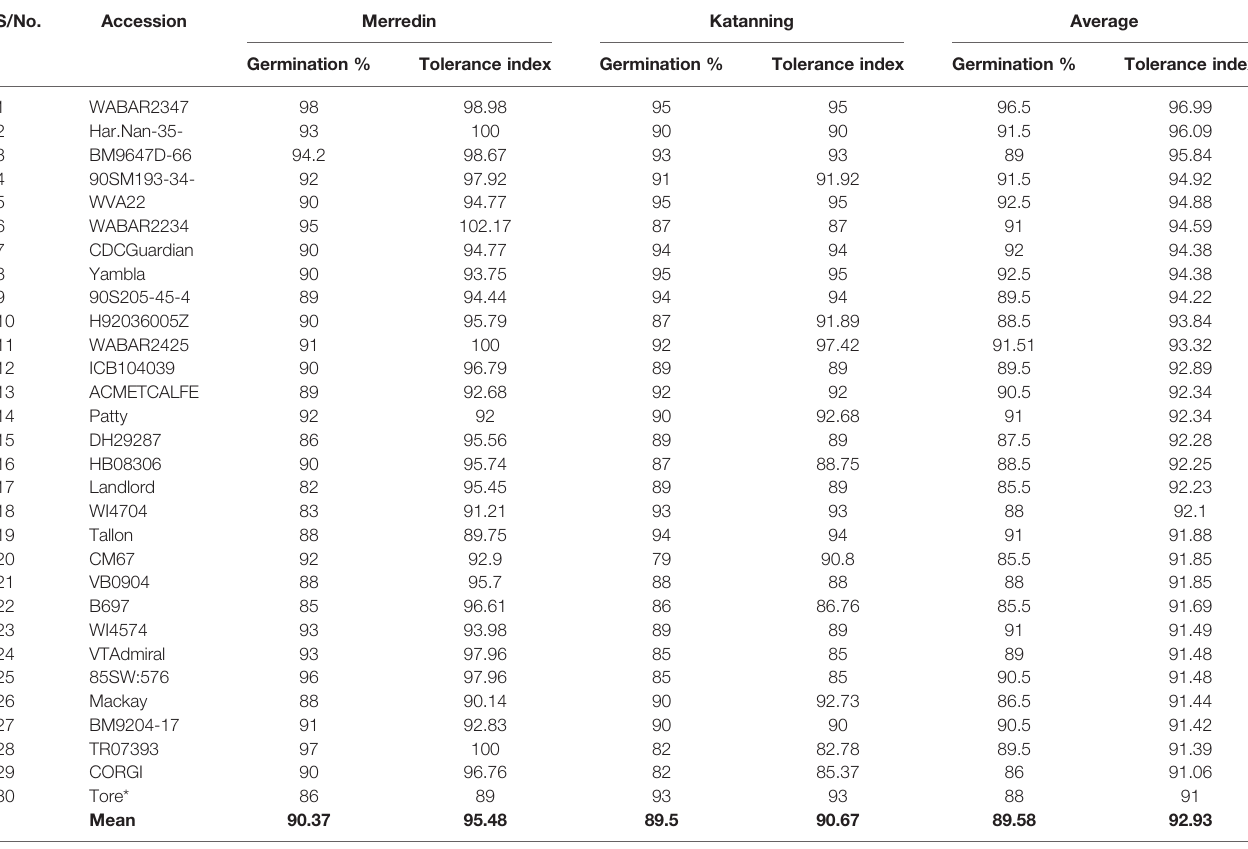
TABLE 2 | List of most tolerant barley accessions (top 30) for seeds sourced from Merredin and Katanning (Western Australia). S/No.